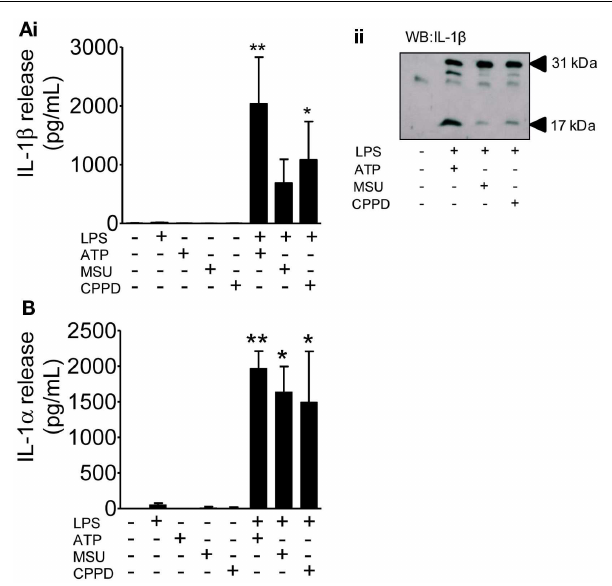
FIGURE 4 |The effects of PAMPs and DAMPs on the release of IL-1 from cultured mixed glia. Cultured mixed glia were treated (1h) with the NLRP3-activating DAMPs ATP (5mM), MSU, and CPPD (both 250 µ g/ml) plus and minus a 24h priming stimulus with the PAMP LPS (1 µ g/ml). Release of both IL-1 β (A) and IL-1 α (B) were quantified by ELISA (Ai) , and processing of pro- (31kDa) to mature (17kDa) IL-1 β in PAMP and DAMP treated cells was analyzed byWestern blot (Aii) . Data are pooled samples from at least five separate experiments. ** P < 0.01, * P < 0.05 vs.